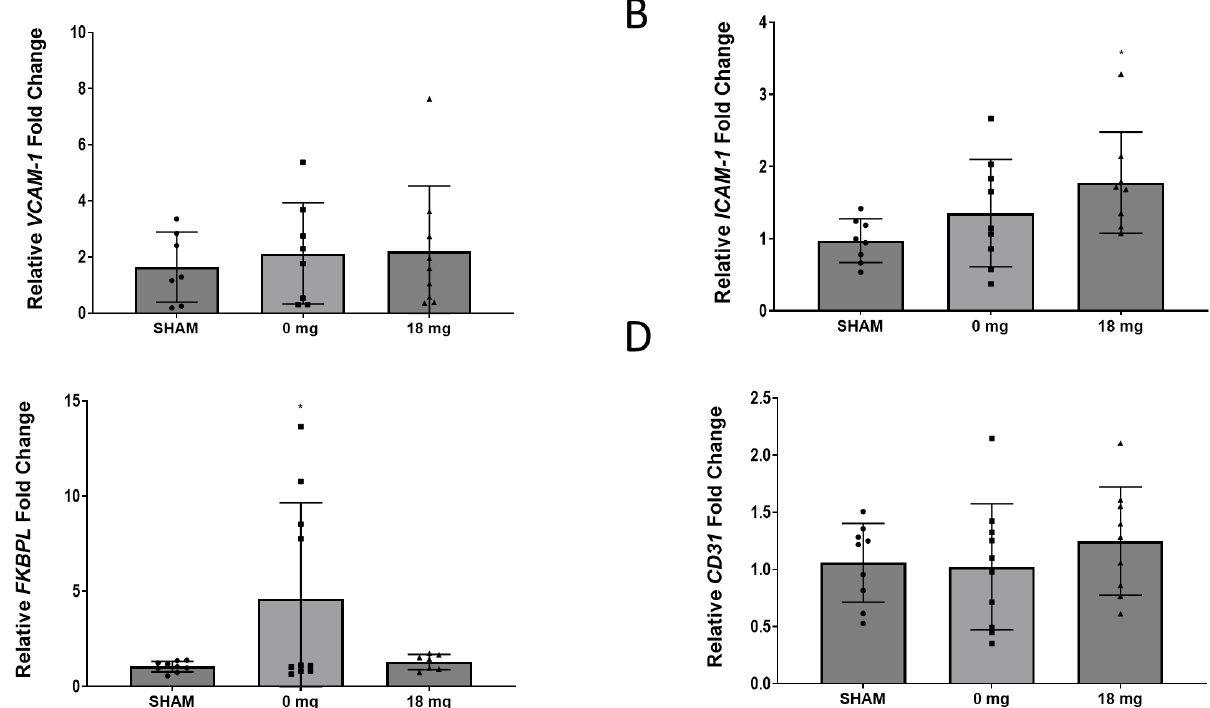
Figure 5. Cardiac VCAM1, ICAM1, and CD31 mRNA expression following treatment of mice with e-cigarettes with or without nicotine. RT-qPCR was performed on the left ventricle of mice exposed to ambient air (SHAM) or e-Cig aerosol (0 mg, 18 mg nicotine). ( A ) FKBPL. ( B ) CD31. ( C ) VCAM-1. ( D ) ICAM-1. All data expressed as mean fold change ± SEM (n = 5–9). One-way ANOVA with Bonferroni post-test was used for statistical analysis, * p < 0.05 versus Sham.